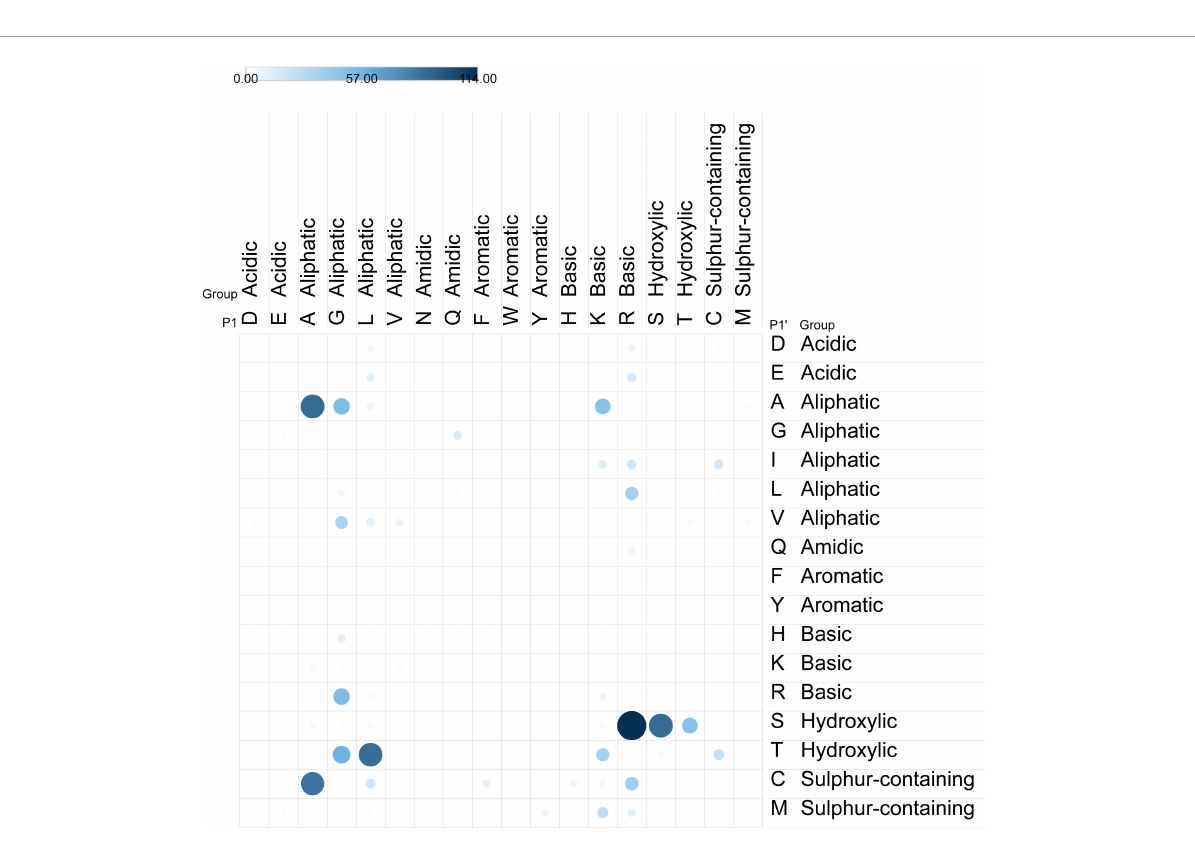
FIGURE4 Cleavage sites observed in caricain-digested peptides. Dot color and size indicates frequency of observed P1-P1’ pairs in primary filtrate peptides. The observed caricain cleavage sites demonstrate preferential cleavage between aliphatic residues at R-S, followed by A-A, S-S, L-T, and